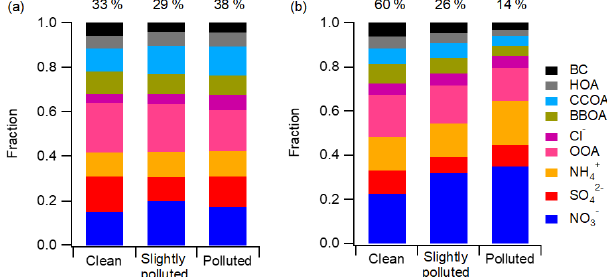
Figure 3. Aerosol chemical composition at different pollution levels in the (a) winter of 2014 and (b) winter of 2017. The contributions of each pollution level are shown at the top of each bar.